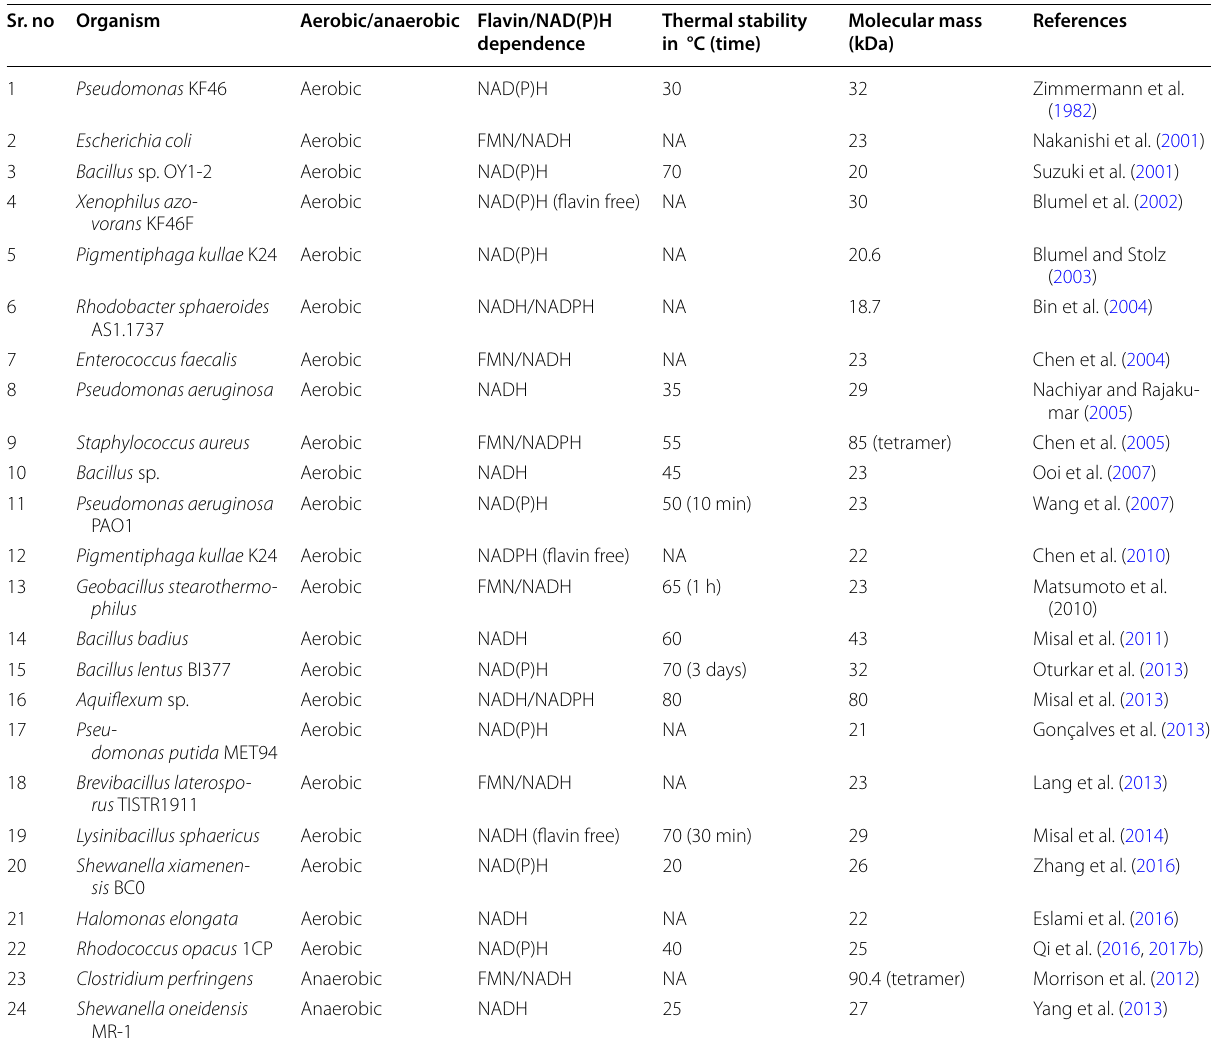
Table 1 Summary of known azoreductases from different bacteria